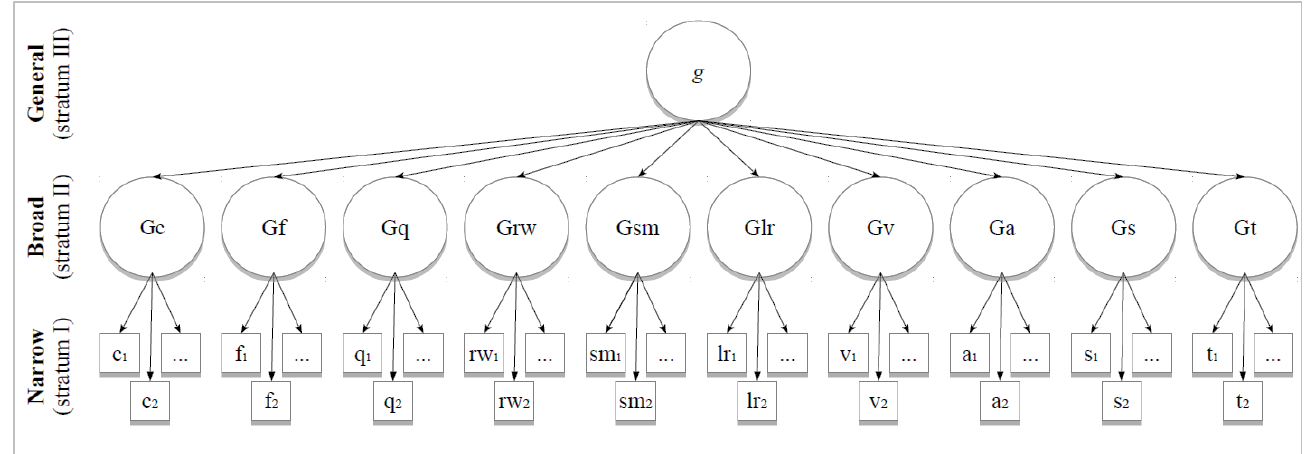
Figure 1. Cattell – Horn – Carroll ’s three-stratum model (adapted from [35]). Figure 1. Cattell–Horn–Carroll’s three-stratum model (adapted from